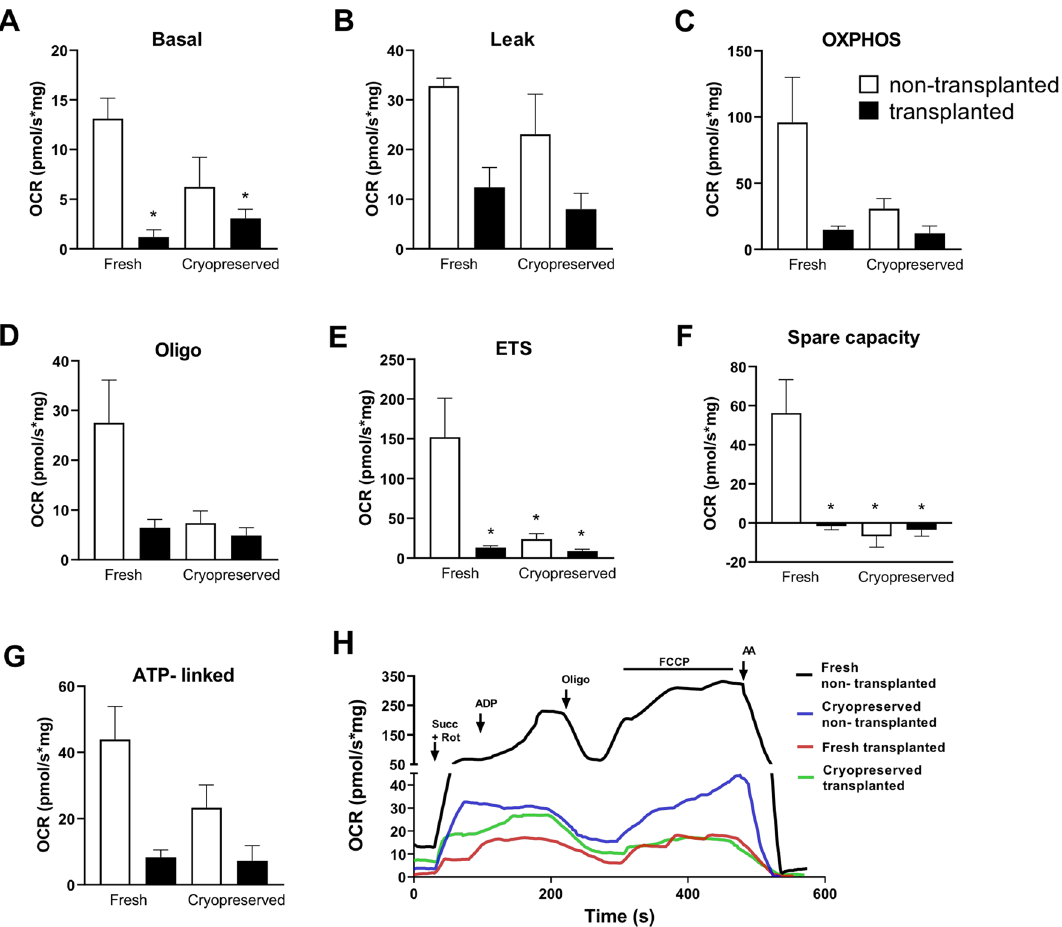
Figure 1. ( A – E ) Effect of cryopreservation and/or transplantation on oxygen consumption in homogenates of hemi-ovaries. Oxygen flux was evaluated using a substrate-uncoupler-inhibitor titration protocol (SUIT). Average O 2 consumption rates (OCR) measured at 5 points of the evaluation, namely ( A ) Basal (O 2 consumed due to oxidation of endogenous substrates); ( B ) LEAK (O 2 consumed due to oxidation of exogenous succinate); ( C ) OXPHOS (OCR related to oxidative phosphorylation); ( D ) Oligo (OCR not dependent on ATP synthesis); ( E ) ETS (maximal respiratory rate resulting from uncoupled mitochondrial respiration). Assessment of reserve mitochondrial capacity (Spare capacity) ( F ) and oxygen consumption directed to ATP synthesis (ATP-linked) ( G ) were also evaluated. ( H ) Representative oxygraph trace of hemi-ovary oxygen consumption during the substrate-uncoupler-inhibitor titration protocol (SUIT) (arrowheads). Respiration rates were measured at 37 °C. O 2 consumption was measured after sequential additions of 10 mM succinate (Succ) and 0.5 µM rotenone (Rot), 500 µM adenosine diphosphate (ADP), 0.1 µg/ml oligomycin (Oligo), Carbonyl cyanide- p - trifluoromethoxyphenylhydrazone (FCCP) (0.1 to 0.4 µM) and 1 µM antimycin (AA). All results were expressed as the mean oxygen consumption rates in pmol of oxygen consumed per second/mg determined by mass of tissue. Data are expressed as the mean ± SEM. * p < 0.05 compared with Fresh non-transplanted group (Two-way ANOVA followed by Tukey’s post-hoc